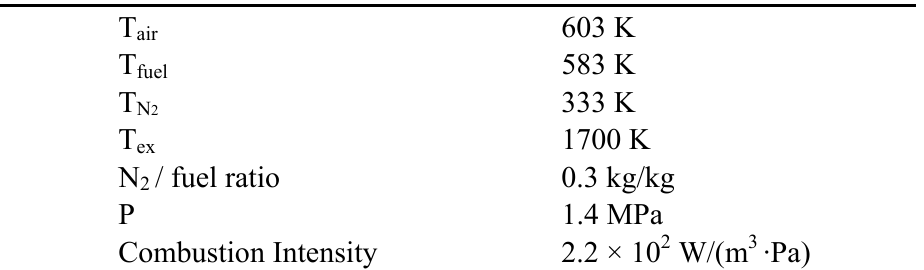
Table 7. Rated test